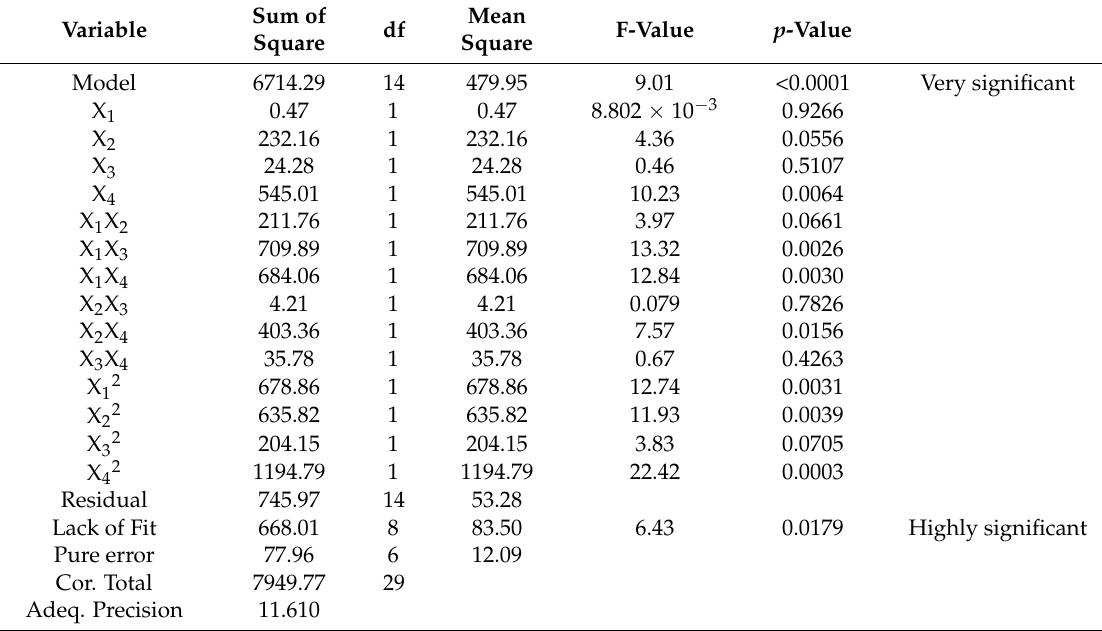
Table 4. Second-order model constants and regression equation coefficients for the